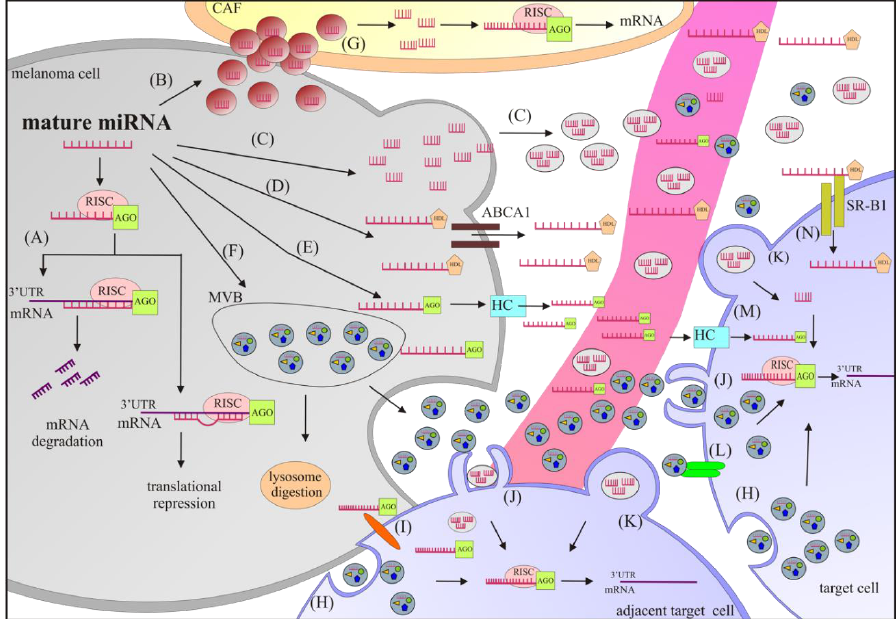
Figure 1. A schematic representation of the functions and cellular release/uptake of miRNAs. ( A )